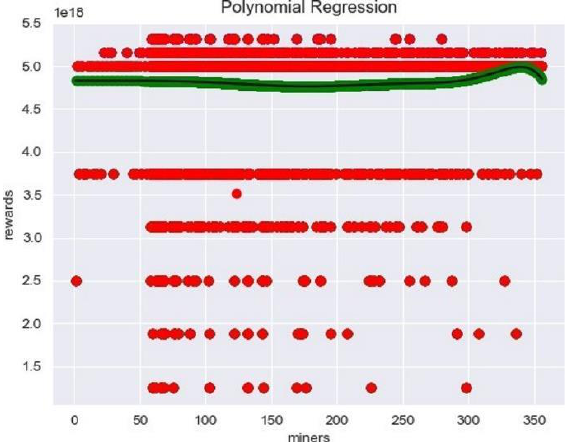
Fig 9. Polynomial Regression with n=’3’.